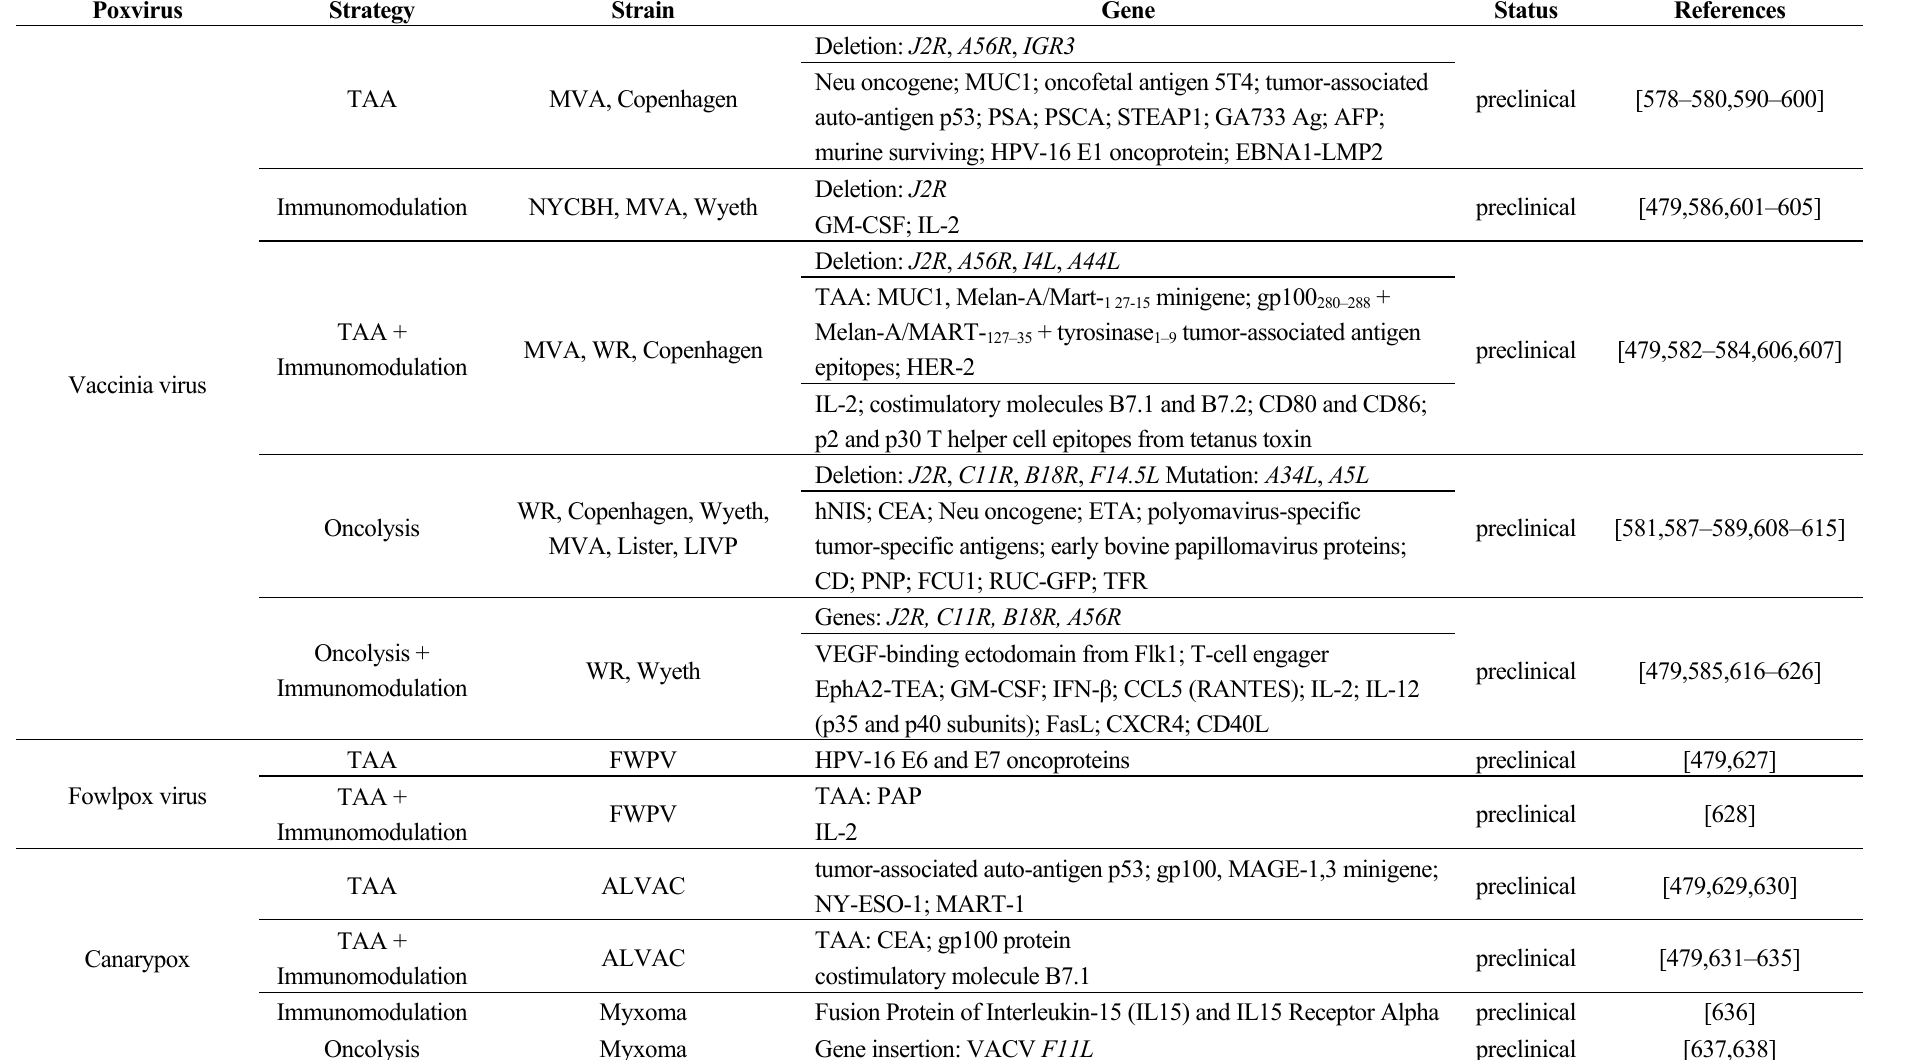
Table 11. Poxvirus-based vaccine candidates against